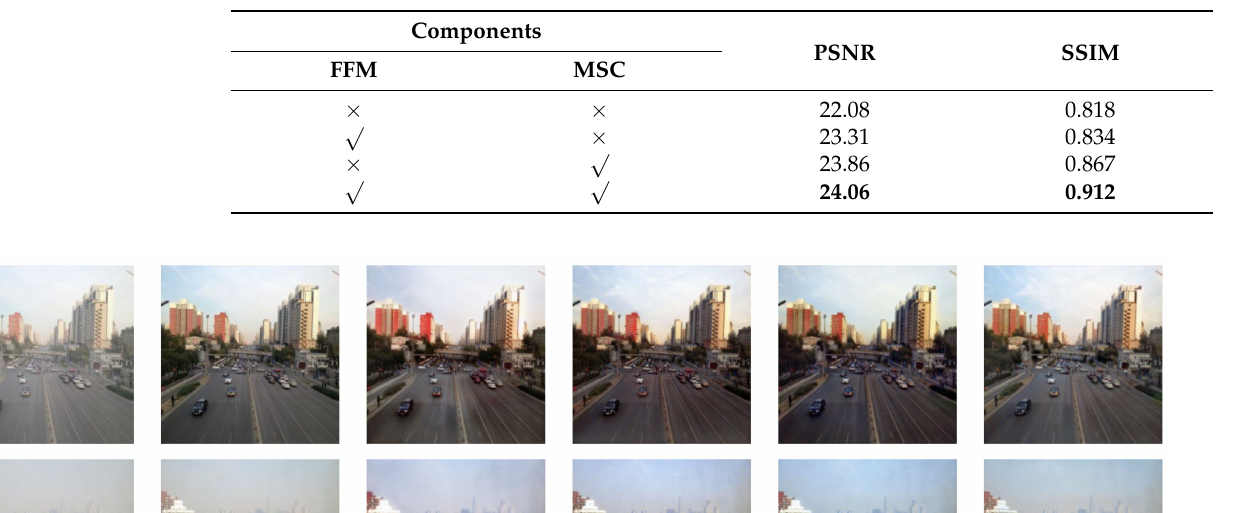
Table 6. Quantitative results on the HSTS.